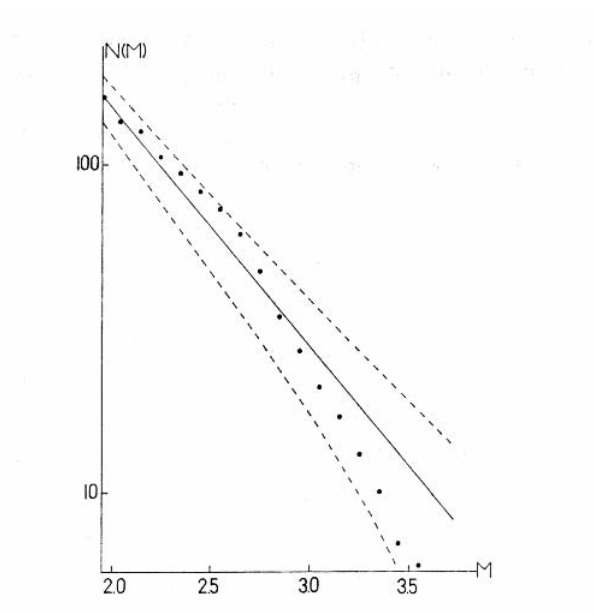
Figure 9. Magnitude-frequency distribution: San Francisco 1957. Figure 10. Magnitude-frequency distribution: Parkfield